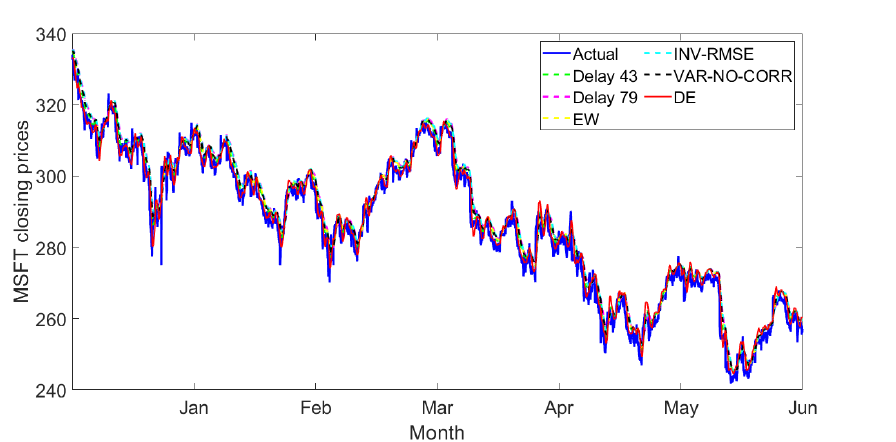
Figure 10. The forecasting curve for actual data versus the individual and combination methods of MSFT stock obtained from the MLP model between January and June 2022.